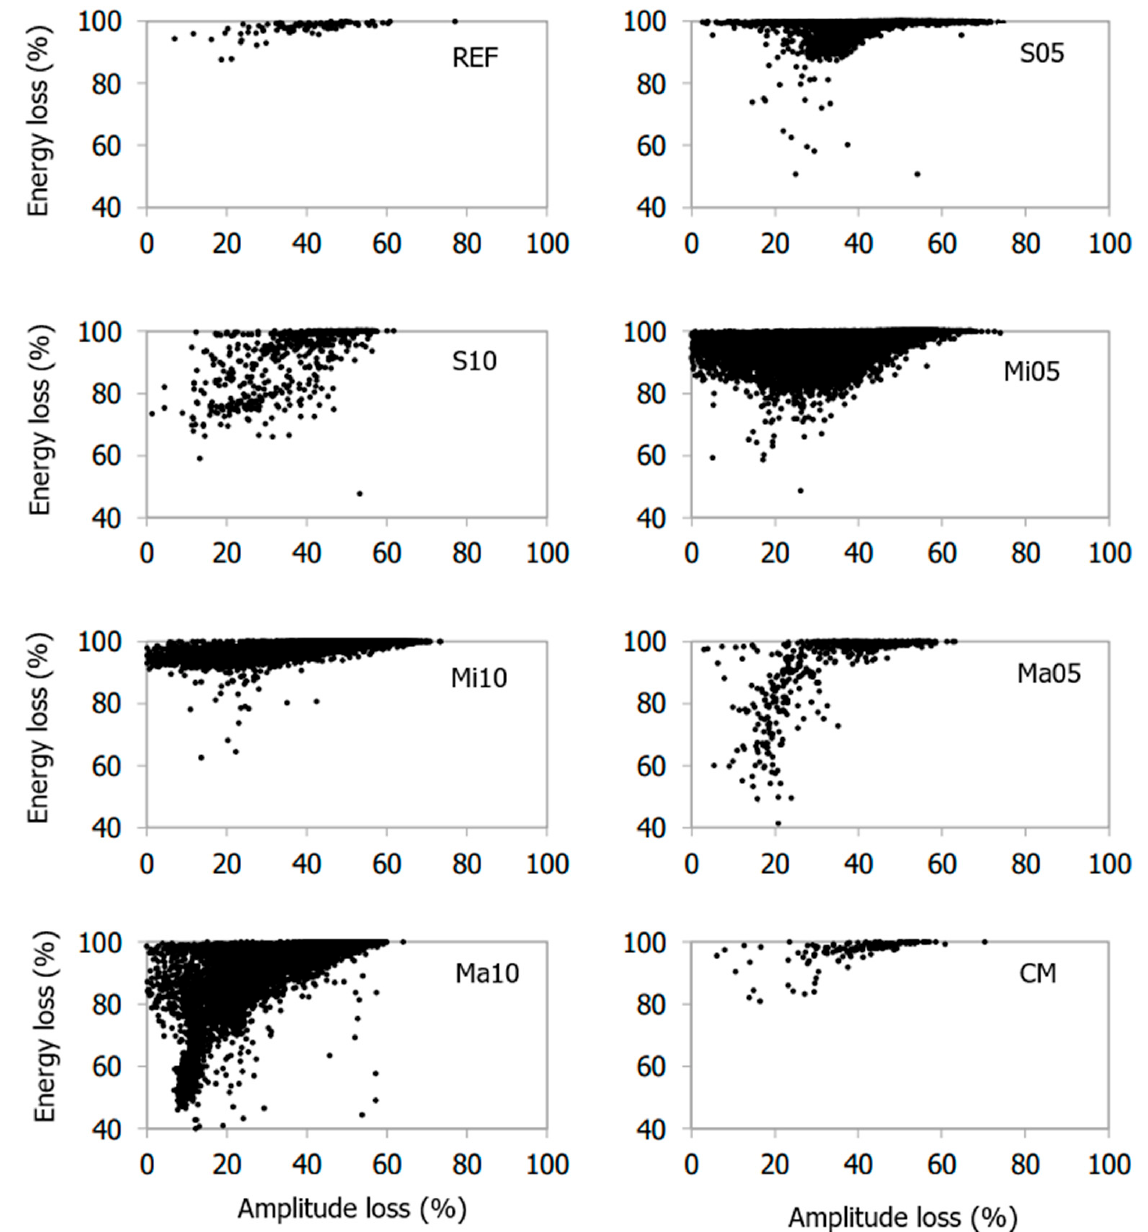
Figure 14. Amplitude and energy losses of the AE activities.